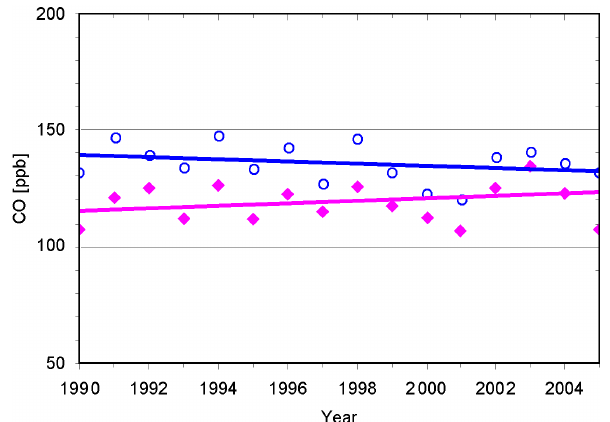
Figure 17. Comparison of the trends for Zugspitze CO based on the annual mean values for all data (upper curve) and the data for periods with stratospheric influence (lower curve).